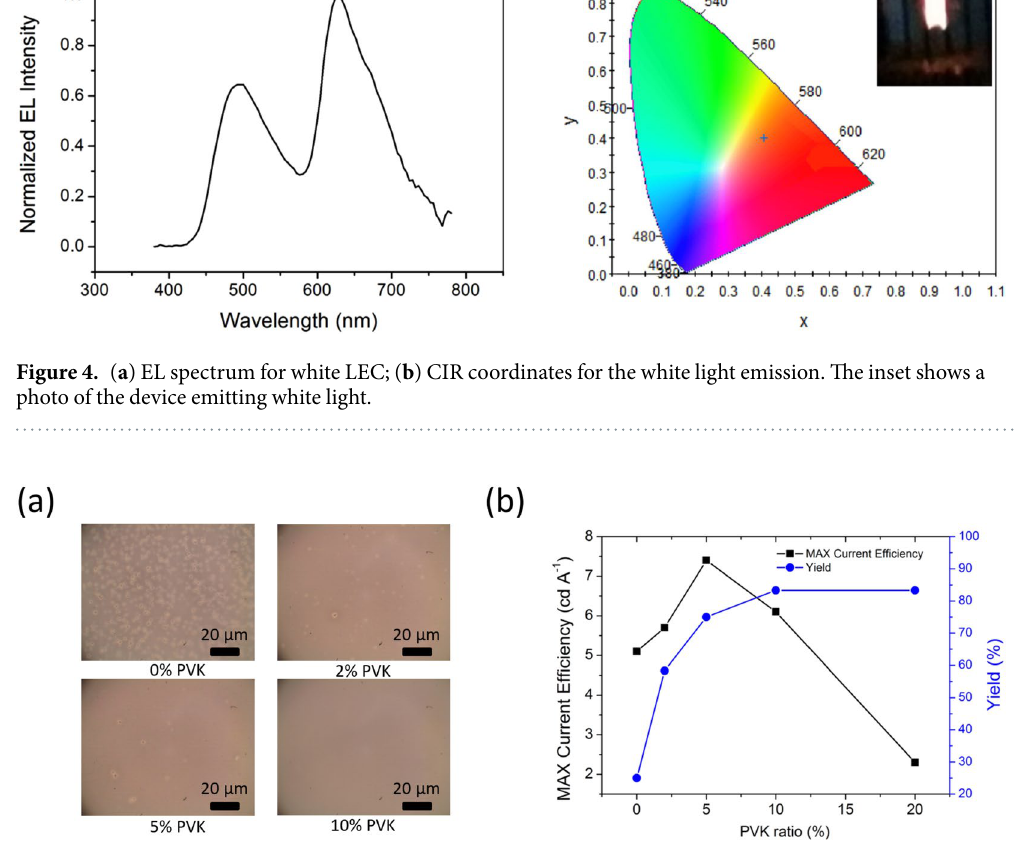
Figure 5. ( a ) Optical microscopic image of as- casted film consisted of PIC-TRZ: G.D.: electrolyte: PVK (0– 10%); ( b ) Dependence of C.E max and yield vs. PVK